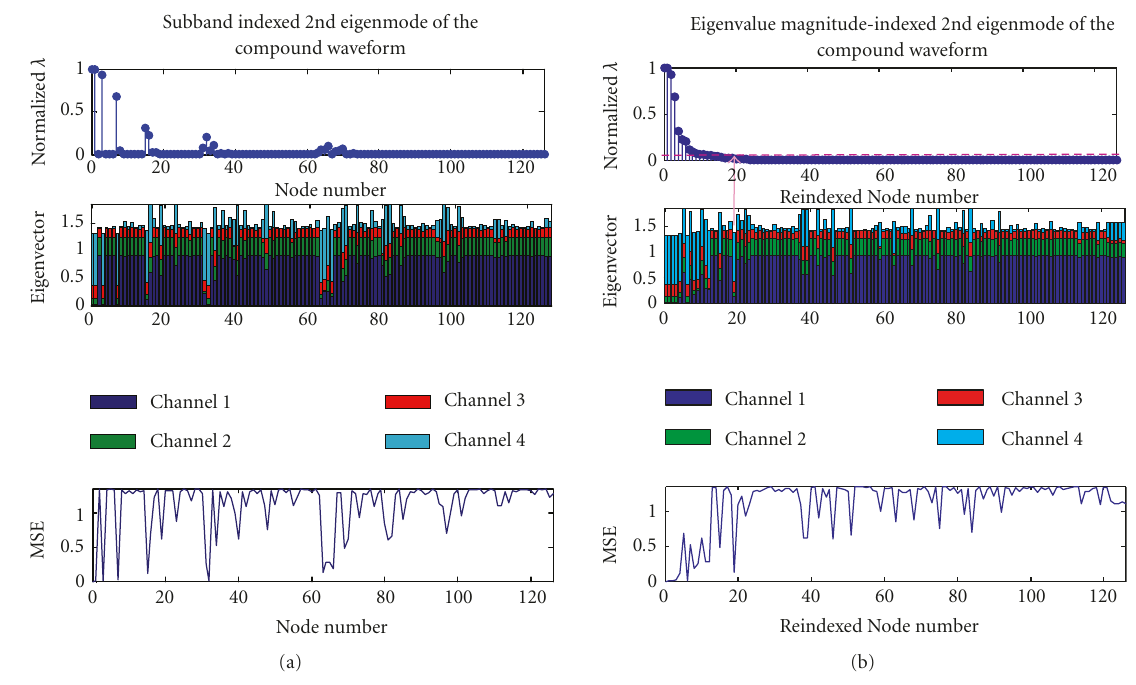
Figure 8: (a) Second eigenmode of the compound waveform in Figure 7(c). The mode is arranged similar to Figure 7(d) based on linear subband indexing. (b) Same features in (a) but reindexing the nodes based on descending order of magnitude of λ a threshold for λ l 2 ( l ∈ J 2 , as indicated by the arrow) that coincides with the last node j ∗ in the sorted sequence having a minimum distance (cid:13) u j ∗ − u 0 (cid:13) 2